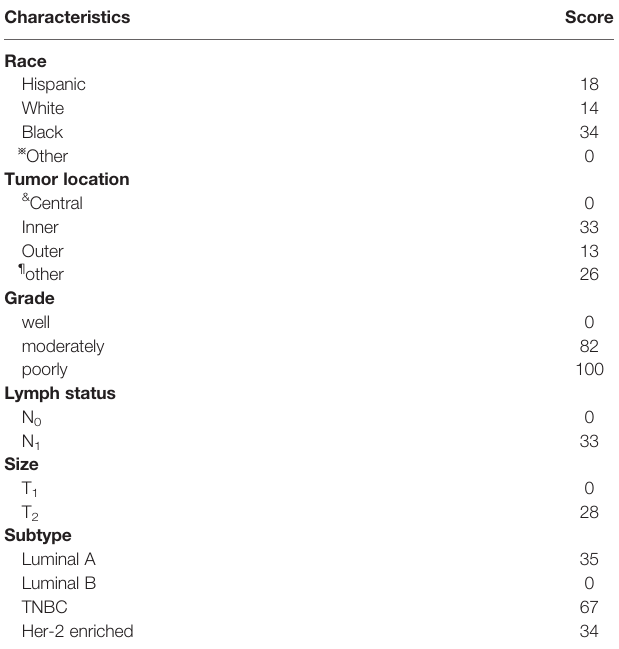
TABLE 3 | The speci fi c value of each variable in the nomogram derives from the multivariate Cox logistic regression results.